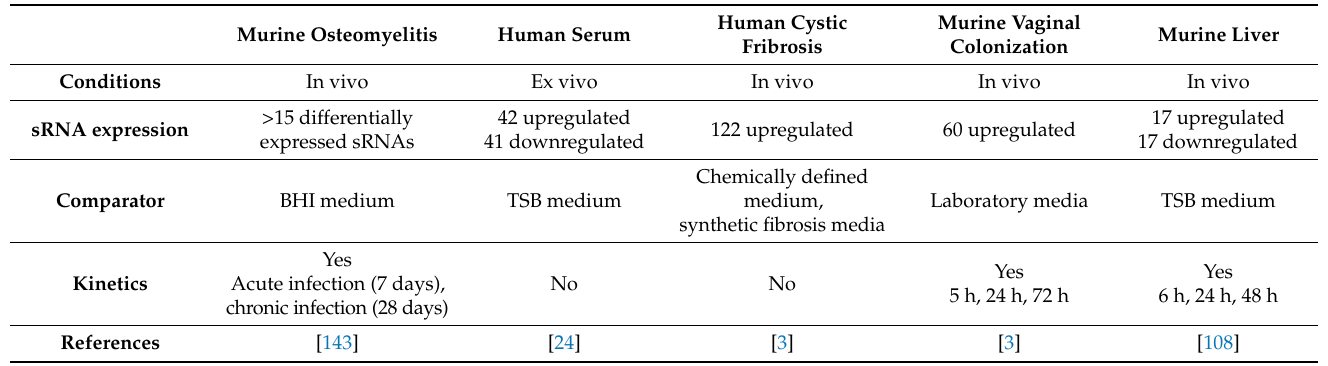
Table 3. sRNA expressions in conditions mimicking human Staphylococcus aureus infections. Expres- sions were obtained by RNA-Seq, including in vivo and ex vivo